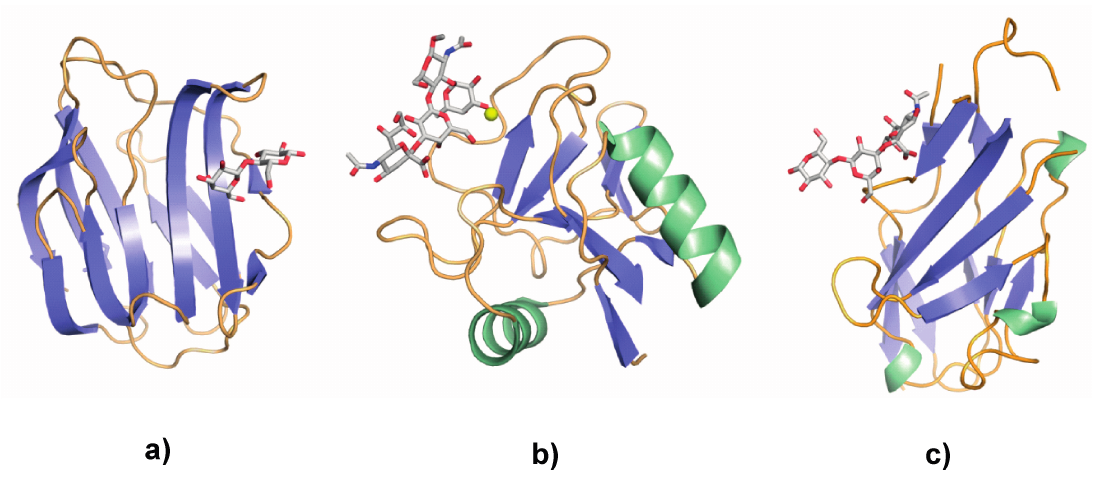
Figure 4. Illustration of three common lectin folds in complex with a